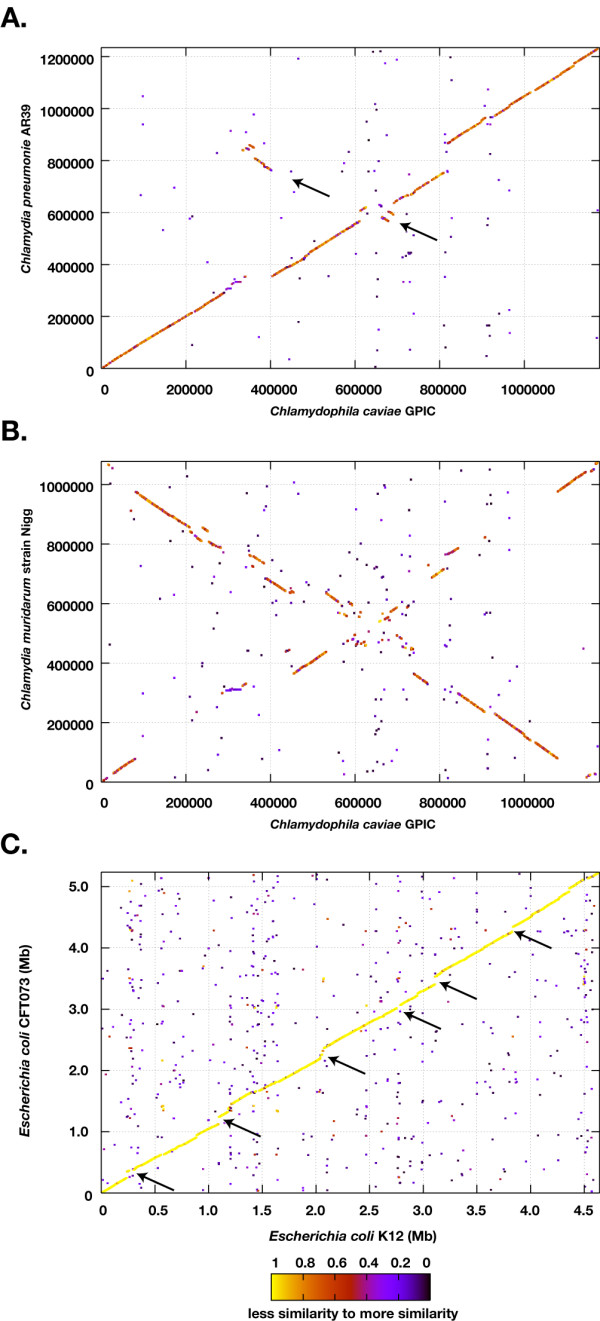
Genome structure visualization. Direct comparison of two genomes at a time demonstrating some examples of large-scale genomic rearrangements. Each protein is plotted by the genomic location of the coding region and is color-coded by the degree of similarity based on the BSR as is demonstrated in the legend. A. Comparison of C. caviae GPIC and C. pneumoniae AR39. This comparison contains two genomic rearrangements of different sizes as indicated by the arrows. B. C. caviae GPIC and C. muridarum strain Nigg comparison reveals a more extensive genomic rearrangements suggesting that while proteomically these organisms are similar the genomes have diverged significantly. C. E. coli CFT073 (GenBank Accession Number AE014075) vs. E. coli K12 (GenBank Accession Number U00096). E. coli CFT073 contains a number of unique insertions that are represented as breakpoints in the plot and highlighted with arrows. The high level of synteny and similarity are exhibited by these genomes.